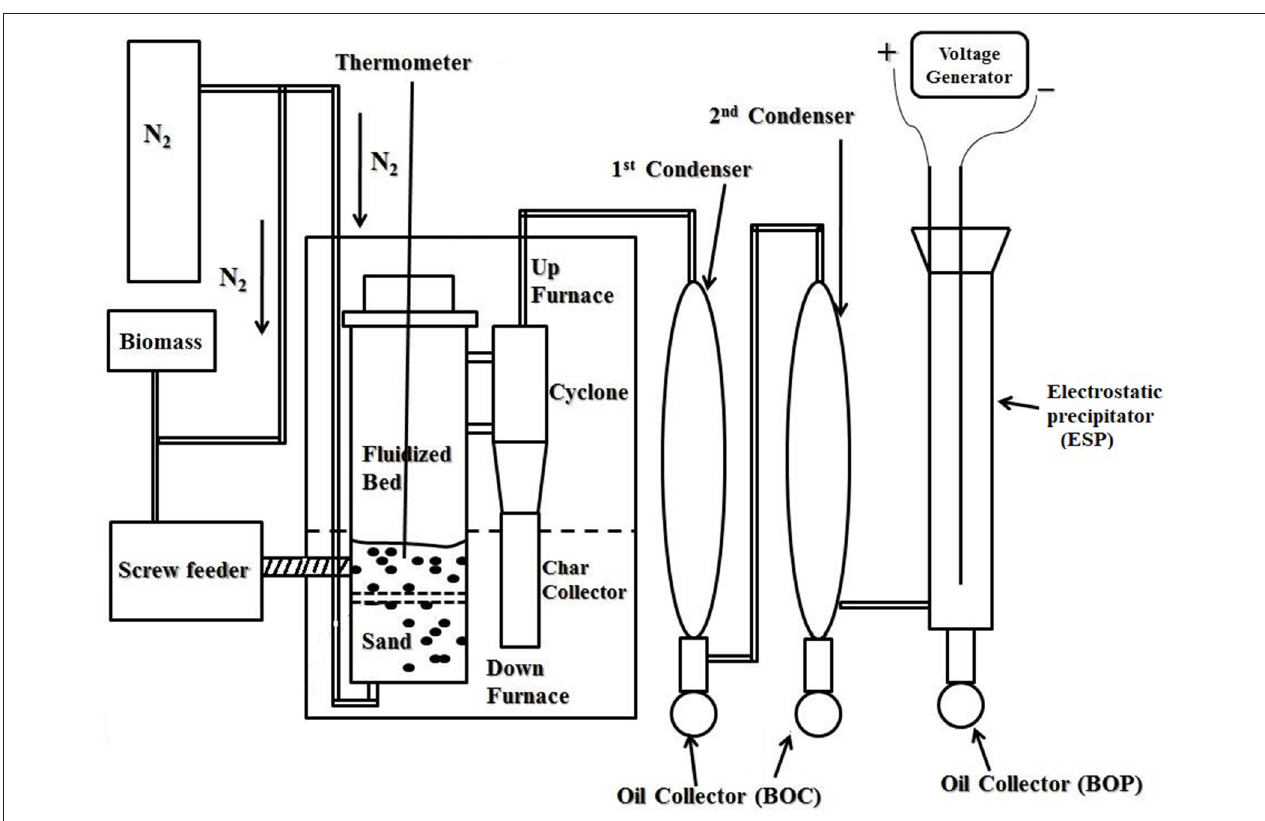
FIGURE 1 | Lab-scale fluidized-bed fast pyrolysis reactor (Meng et al., 2012).